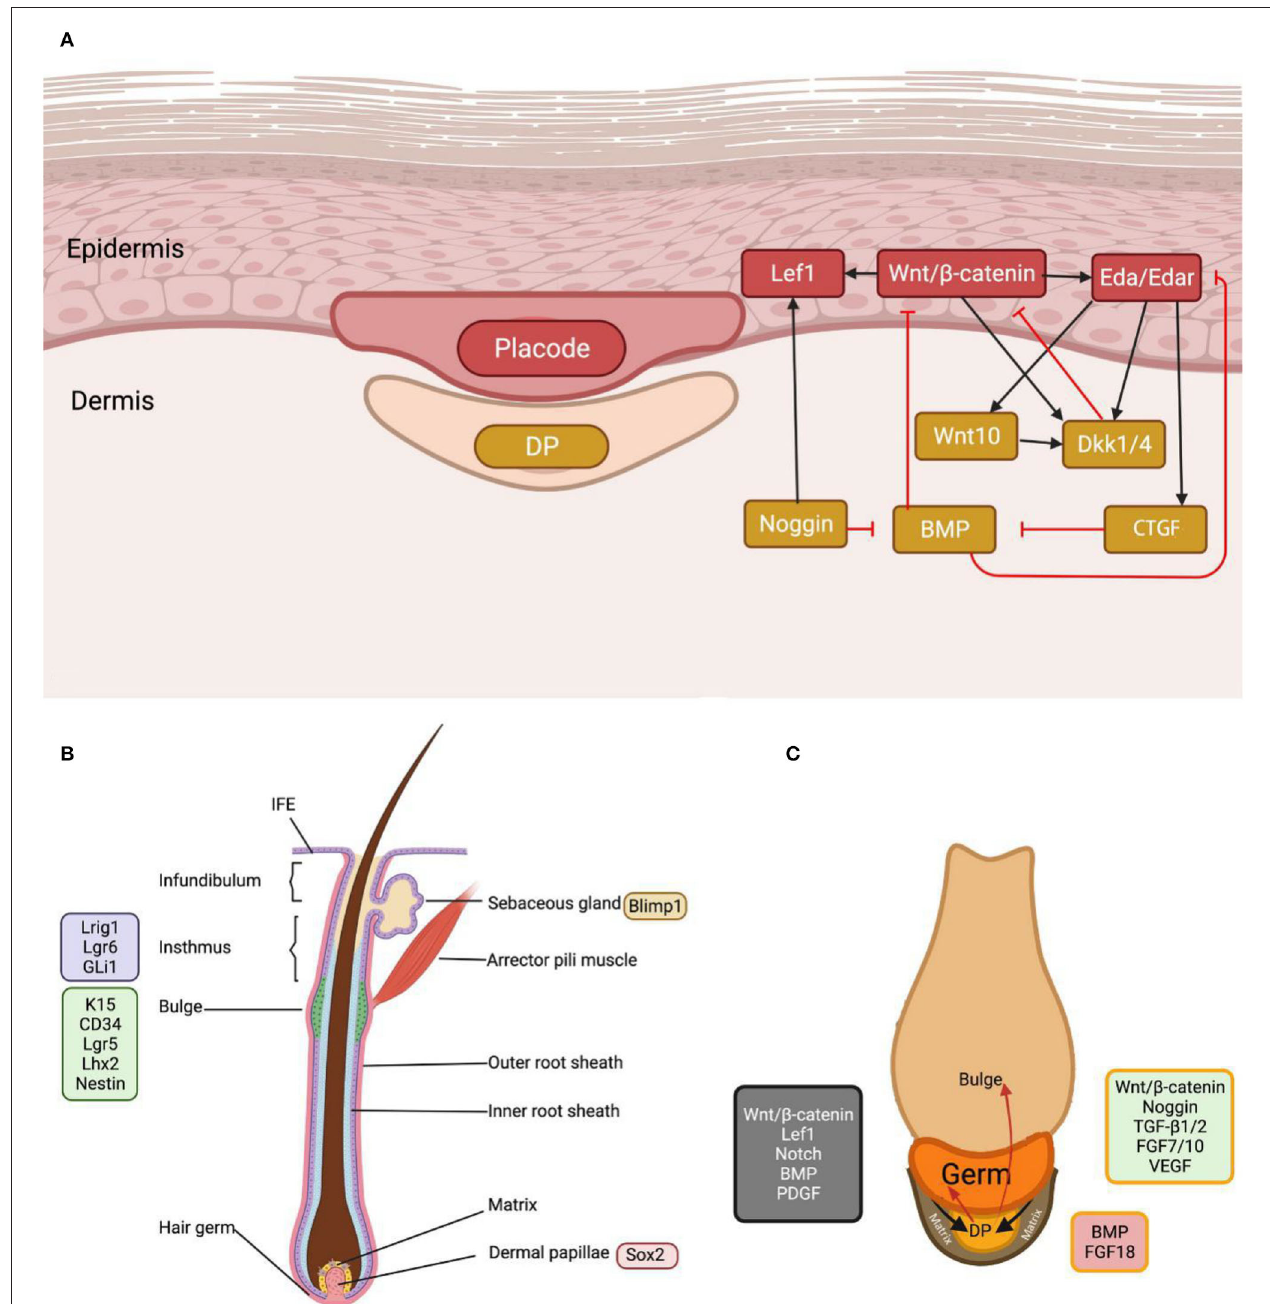
FIGURE 1 | The morphogenesis and cycling of the hair follicle. (A) As the earliest and paramount signal in the first hair wave, Wnt induces placode and dermal condensate formation and intrigues complex inter-signal dynamics. (B) In mature hair follicles, stem cells at different sites can be characterized by specific markers. (C) EMI interaction occurs between DP, hair germ and its progeny, and hair matrix, during hair anagen initiation. The green color in the figure represents DP signals that initiate the anagen, the red color inhibits the hair follicle cycle, and the gray color represents the matrix signals. BMP and FGF18 suppress hair stem cells, whereas Wnt and FGF7/10 activate them. CTGF, connective tissue growth factor; Eda, ectodysplasin A; Edar, ectodysplasin A receptor; DKK, Dickkopf; Gli1, GLI family zinc finger 1; Lef1, lymphoid enhancer-binding factor 1; Lgr, leucine-rich repeat-containing G-protein coupled receptor; Lhx2, LIM homeobox 2; Lrig1, leucine-rich repeats and immunoglobulin-like domains protein